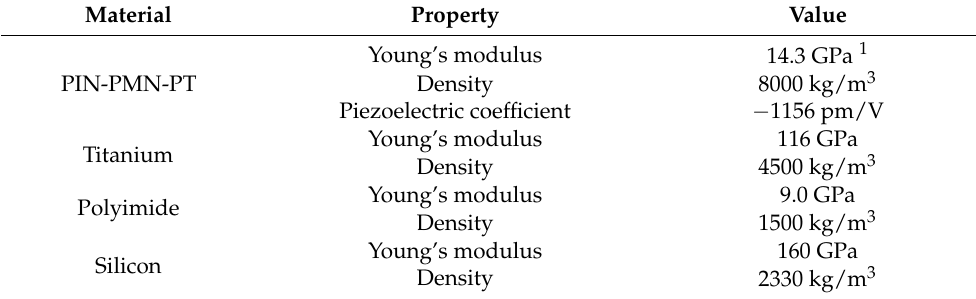
Table A1. Material properties used in FEA.